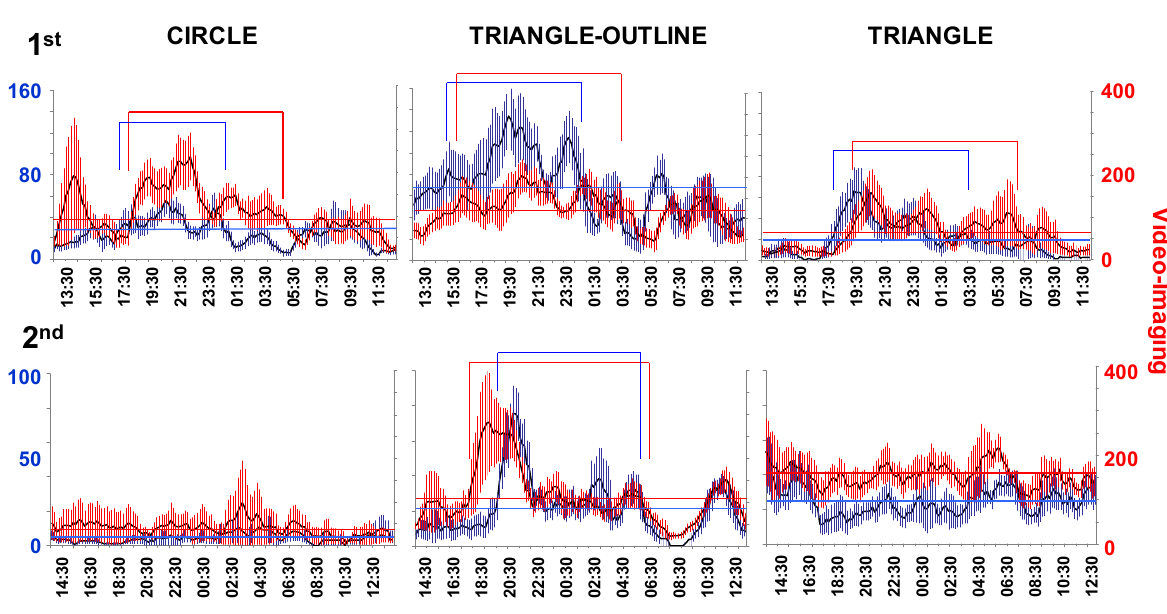
Figure 6. Comparisons of waveform analysis outputs between locomotion activity time series (cm ± SEM) that were measured over the first (1st) and second (2nd) day-night experiment using RFID (blue) and automated video-imaging (red) tracking methods for three Nephrops held together in a laboratory microcosm tank. The MESOR is the horizontal line. The arrows indicate the onset and offset of peaks ( i.e. , values above the MESOR) and are used for a comparison between the two tracking